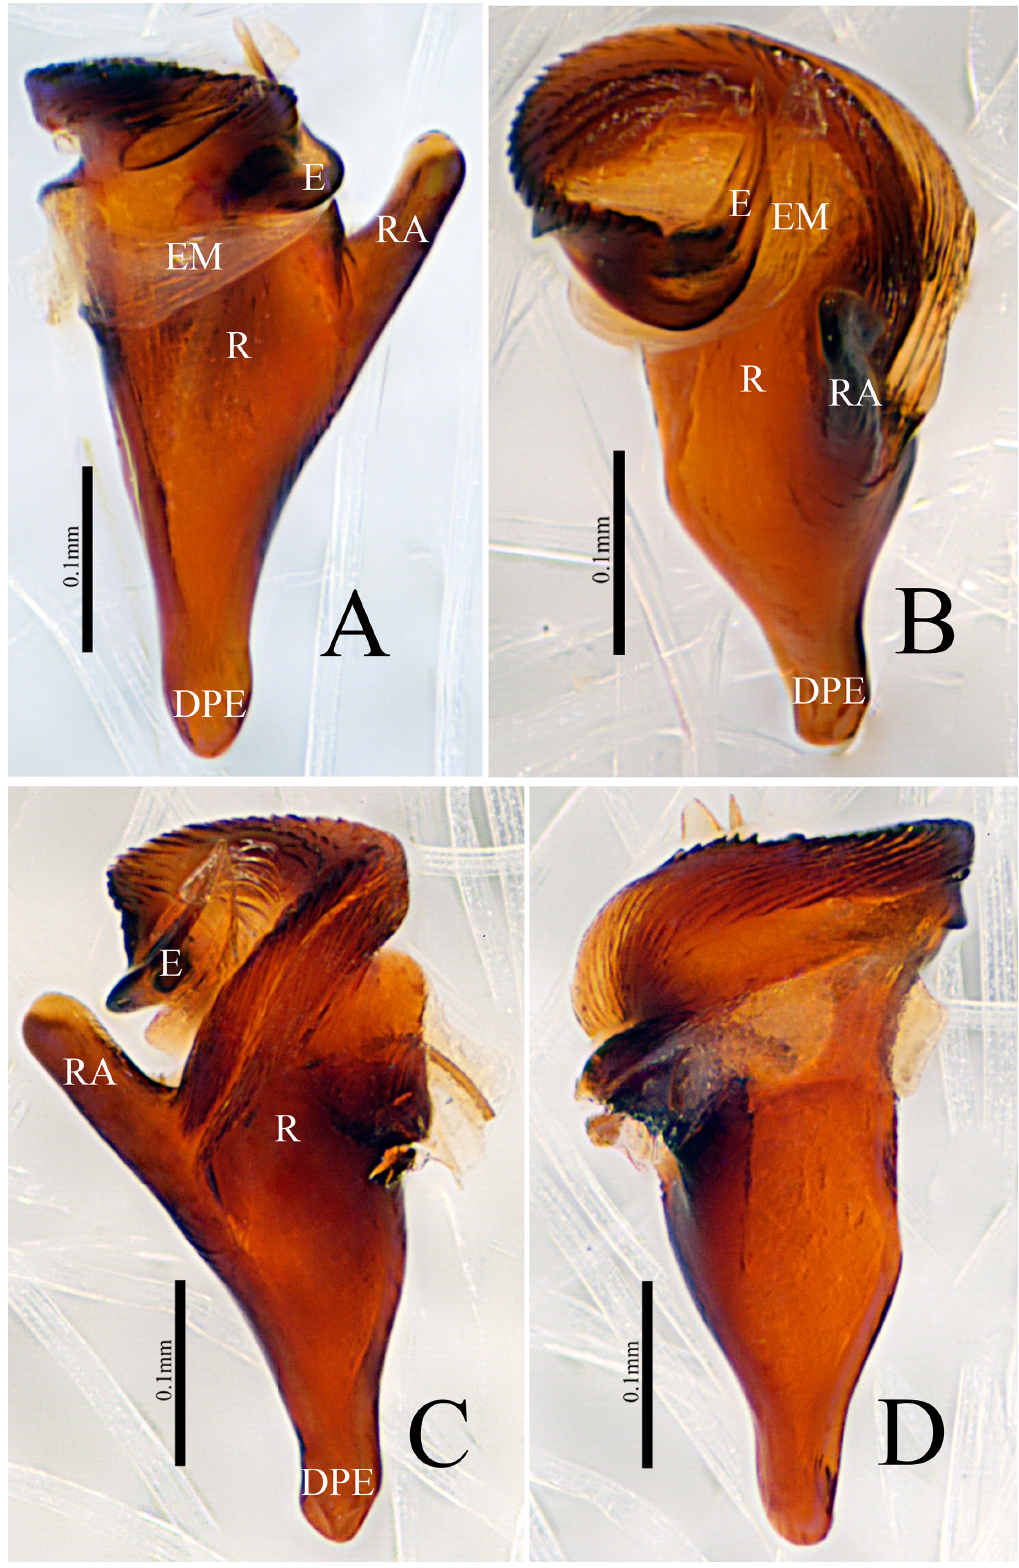
Fig. 11. Acroterius camur gen. et sp. nov., ♂, holotype (HNU-DHK–2002–038). A–B . Embolic division, ventral view. C . Embolic division, prolateral view. D . Embolic division, dorsal